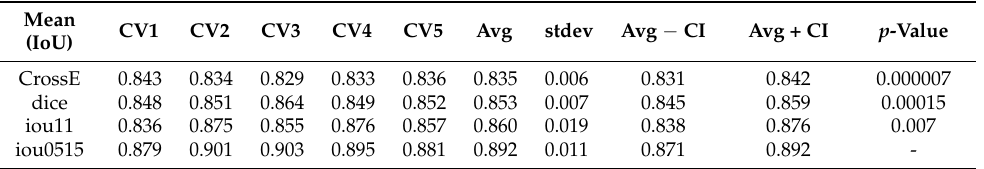
Table 4. IoU of segmentation network DeepLabV3 for diff folds (CVi = cross validation fold) on MRI. Mean CV1 CV2 (IoU)